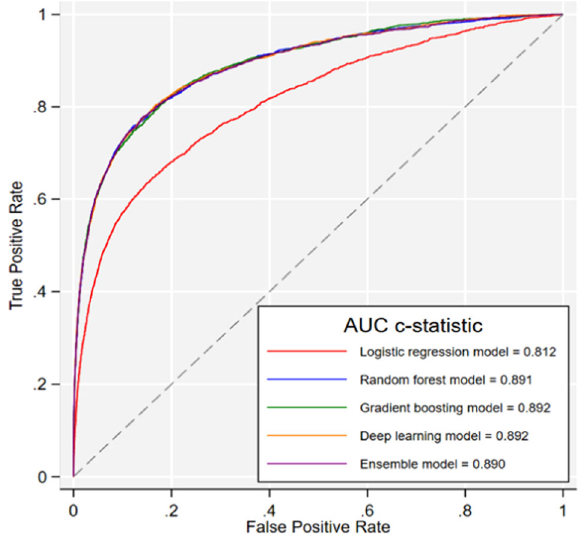
Fig. 3 Discrimination accuracy of the models for identifying familial hypercholesterolaemia in primary care. Based on valida- tion cohort of 1,006,943